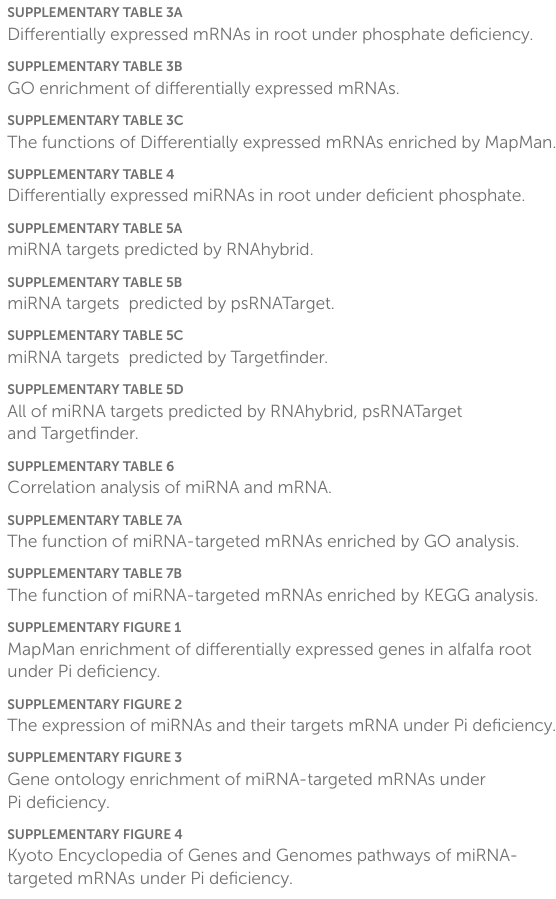
target genes for qRT-PCR assay. SUPPLEMENTARY TABLE 2 Overview of obtained RNA-Seq data from alfalfa root under phosphate deficiency.